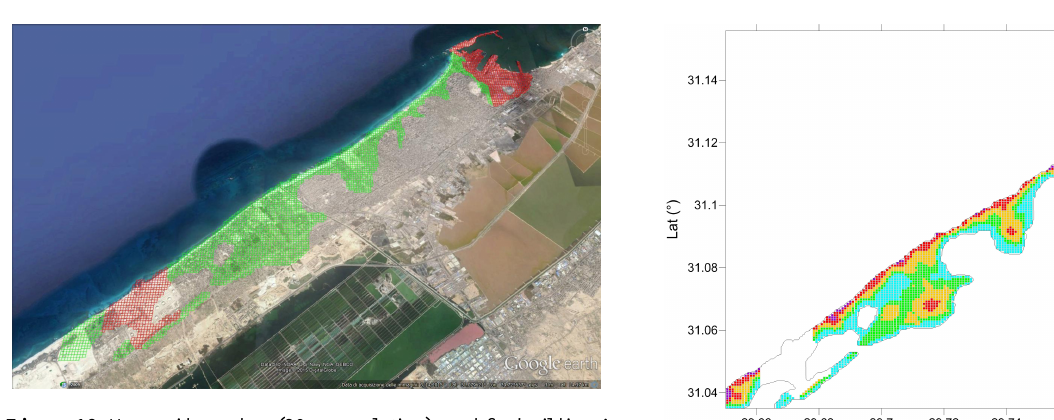
Figure 19. Map with meshes (80m resolution) used for buildings’ vulnerability assessment focussed on the zone south-west of the Dekhila port. The green mesh covers the area of inundation, while the red one is a subset covering the area of Dekhila port (north) and the area of APC refinery (south) not considered for the vulnerability analysis. Assumption is made of mean-sea-level conditions.